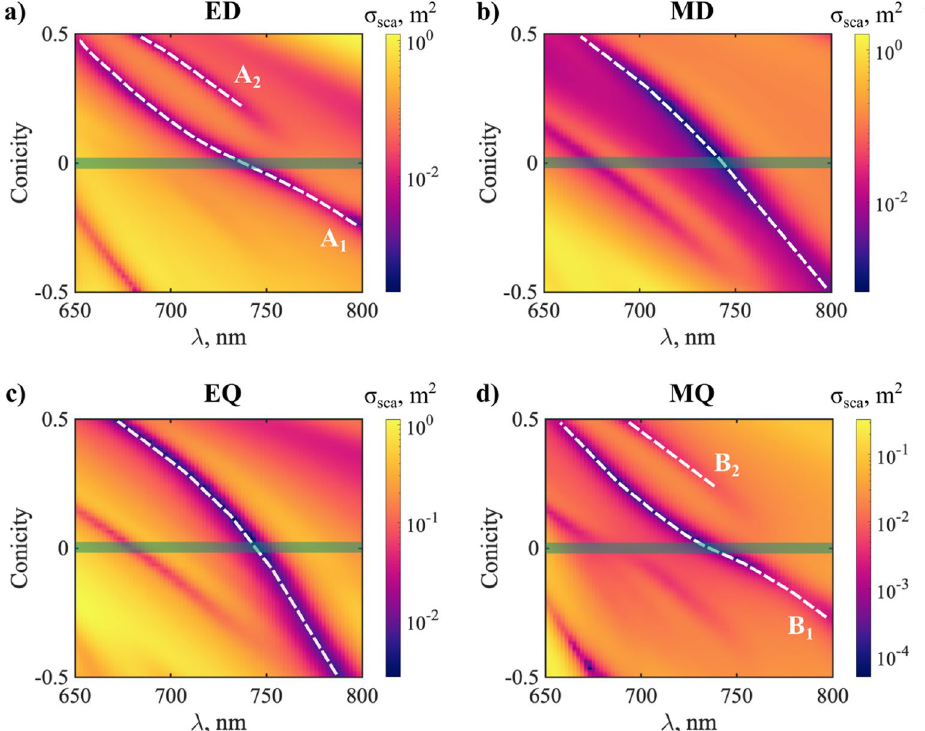
Figure 6. Evolution of the SCS of each multipole (in log scale), as a function of wavelength and conicity. White dashed lines are a guide to the eye, and indicate the paths traced by anapoles in parameter space. The shaded green lines highlight the unperturbed cylinder (with conicity = 0). ( a ) ED. A 1 labels the original ED anapole in the unperturbed cylinder, and A 2 is the new ED anapole induced by symmetry breaking. ( b ) MD, ( c ) EQ, ( d ) MQ. B 1 labels the original MQ anapole in the unperturbed cylinder, and B 2 is the new MQ anapole induced by symmetry breaking. The experimental dispersion data for a-Si is shown in Supplementary Fig.